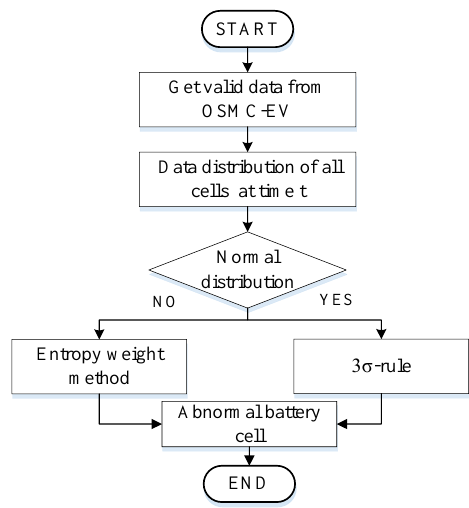
Figure 4. Flow chart of battery fault diagnosis model.